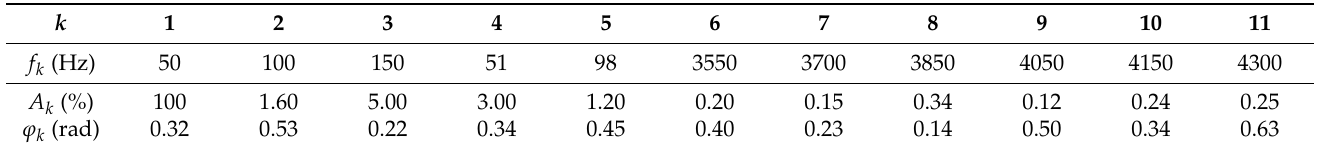
Table 1. Specific parameters of